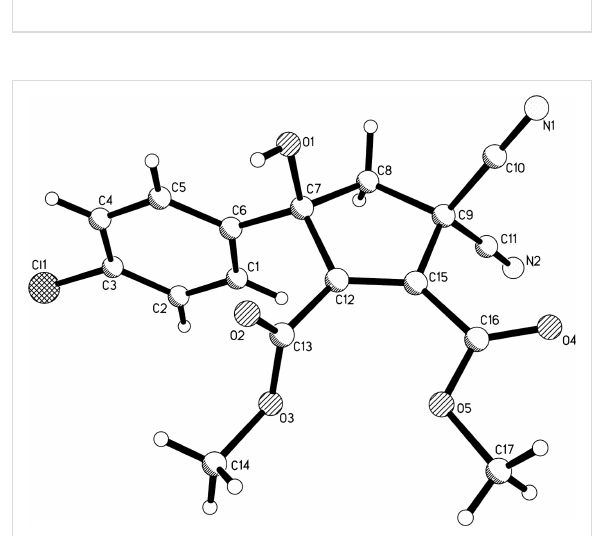
Figure 1: Single crystal structure of compound 3k